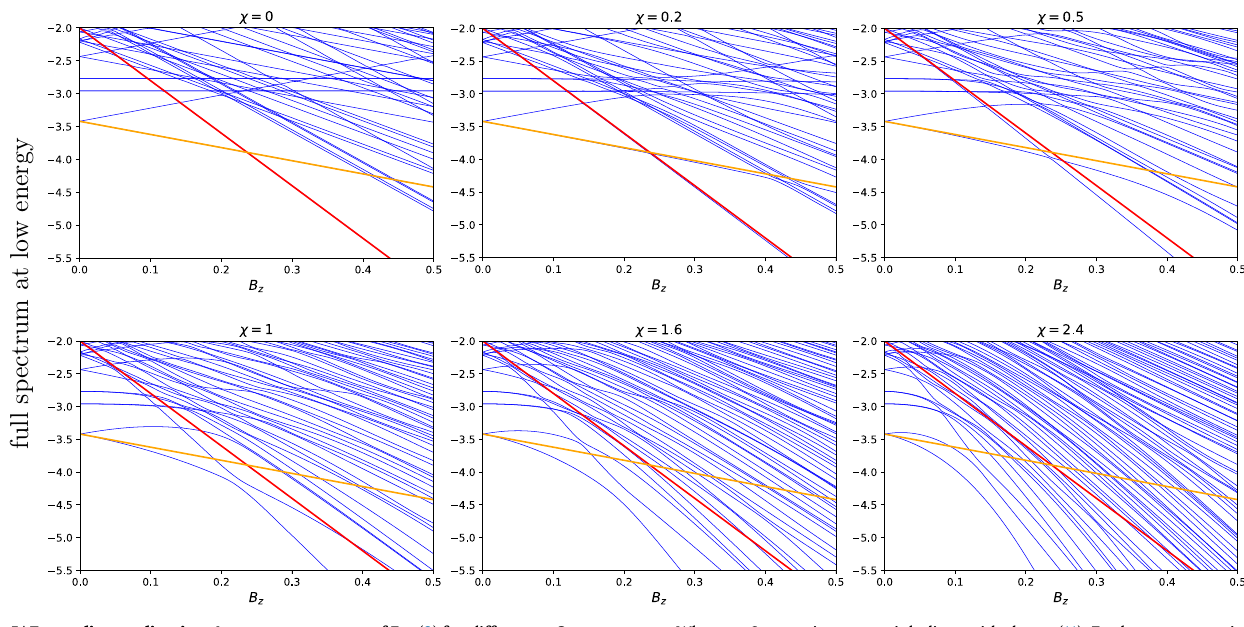
eye.When χ =0,energiesarestraightlineswithslopes(11).Forlarger χ ,energiesare curved down, due to the level repulsion. Simultaneously the gaps open